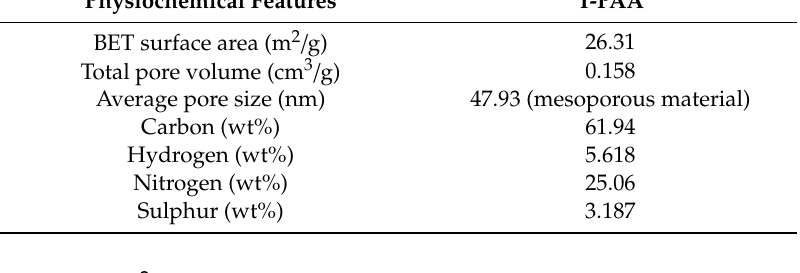
Table 3. Surface characterization of the T-PAA adsorbent.